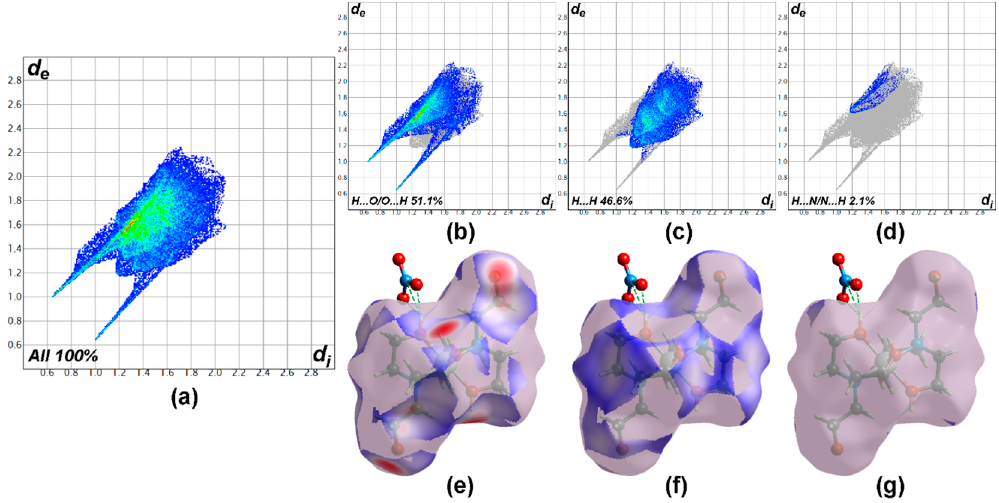
Figure 3. The full two-dimensional fingerprint plot for the Ni-TEA compound, showing ( a ) all interactions and those delineated into ( b ) H ··· O / O ··· H, ( c ) H ··· H and ( d ) H ··· N / N ··· H interactions. The d i and d e values are the closest internal and external distances (in Å) from given points on the Hirshfeld surface (HS). The corresponding HS for ( e ) H ··· O / O ··· H, ( f ) H ··· H, and ( g ) H ··· N / N ··· H is plotted over the d norm range from − 0.7343 to 1.2167 a.u.